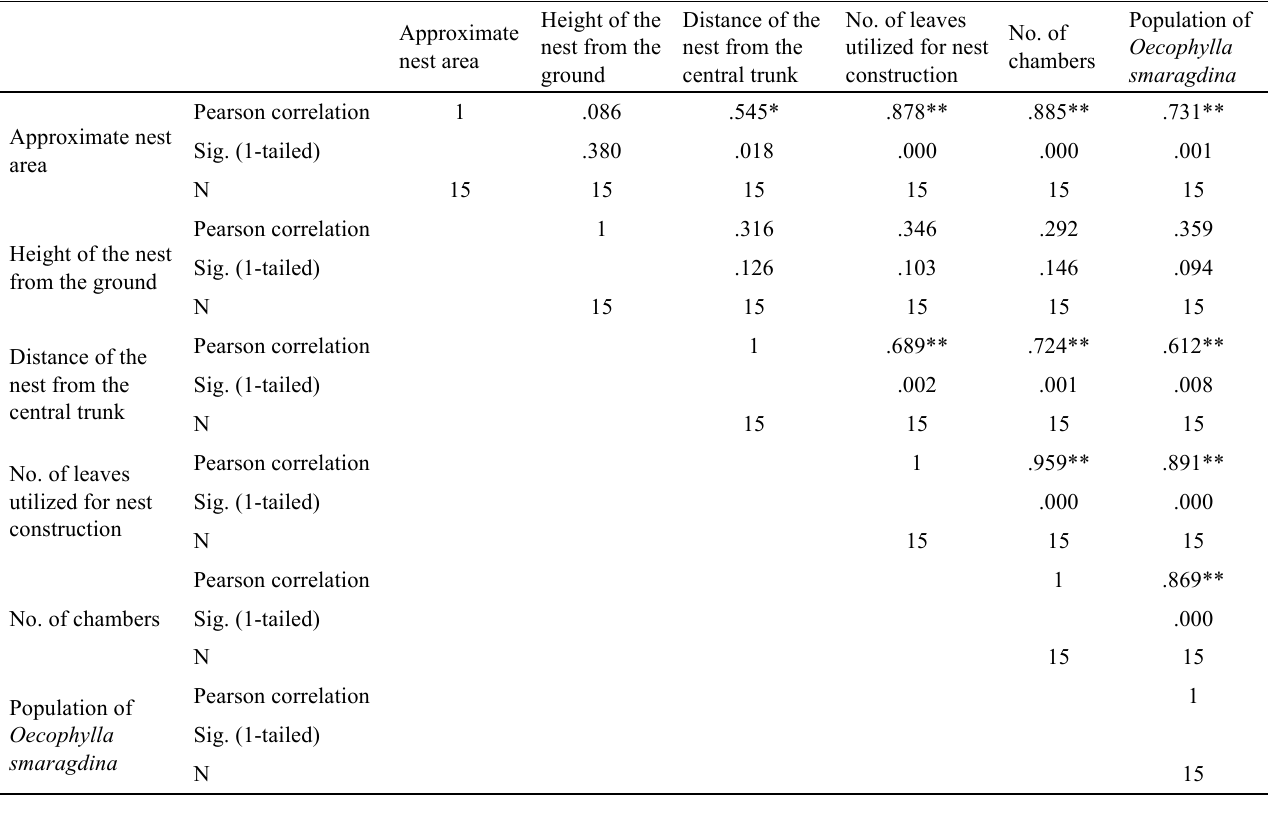
Table 2 . Pearson correlation (one-tailed), n = 15, showing significance at **p ≤ 0.01 and *p ≤ 0.05 comparing the multidimensionality of different variables.